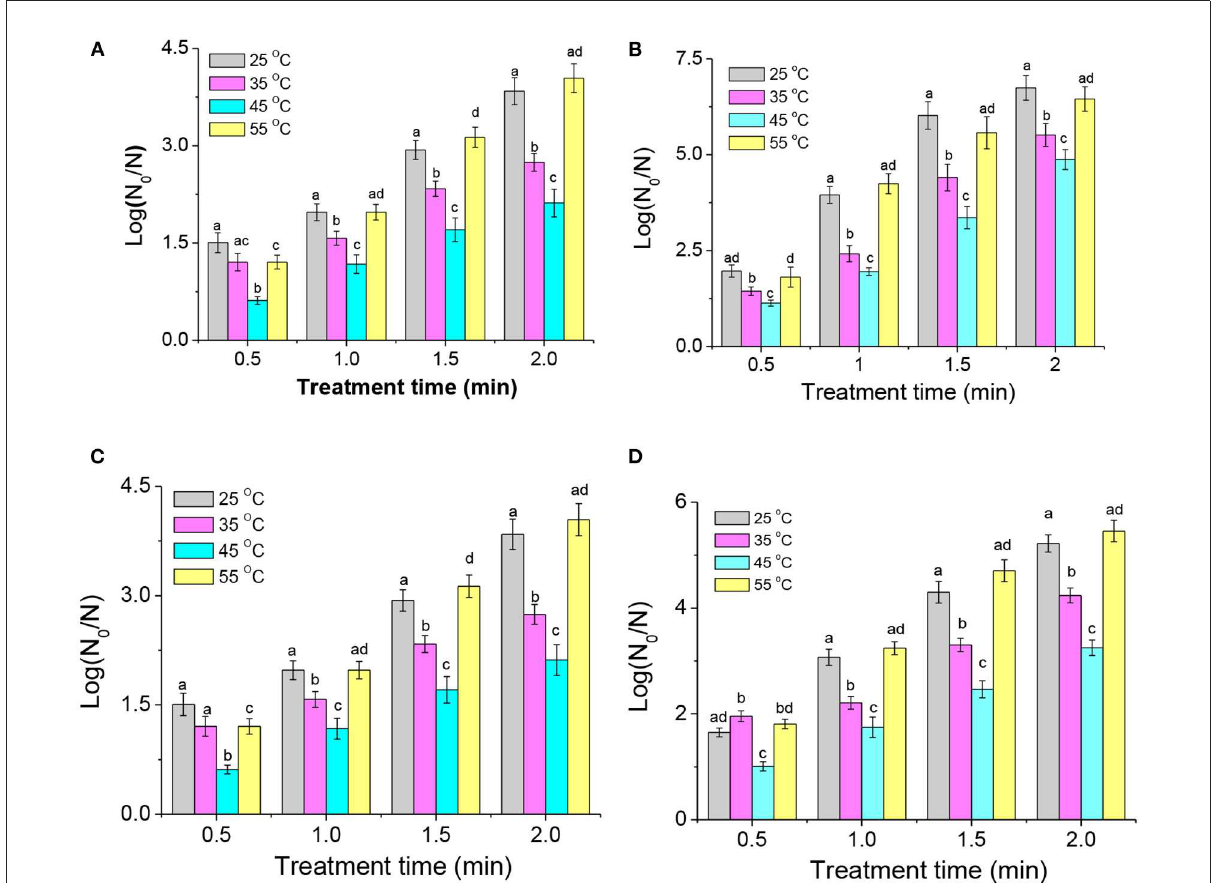
FIGURE5 The effect of growth temperatures on the resistance of A. acidoterrestris cells on the sterile saline solution to DBA-ACP under 20 kV (A) and 30 kV (B) , and apple juice with 20 kV (C) and 30 kV (D) for different treatment times. Different letters (a–d) on the top of the bars denote significant differences ( p <